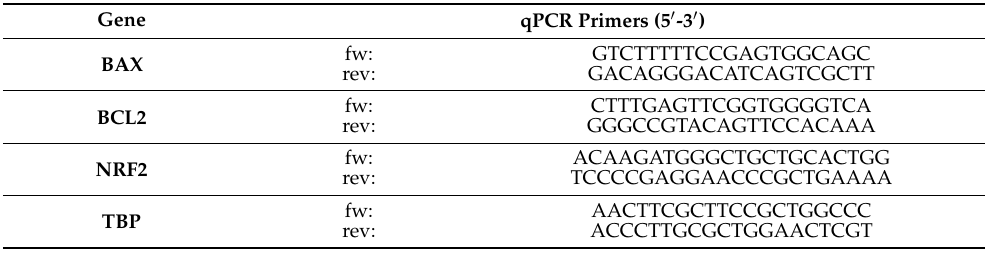
Table 2. Forward and reverse sequences of specific primers used in real-time PCR.